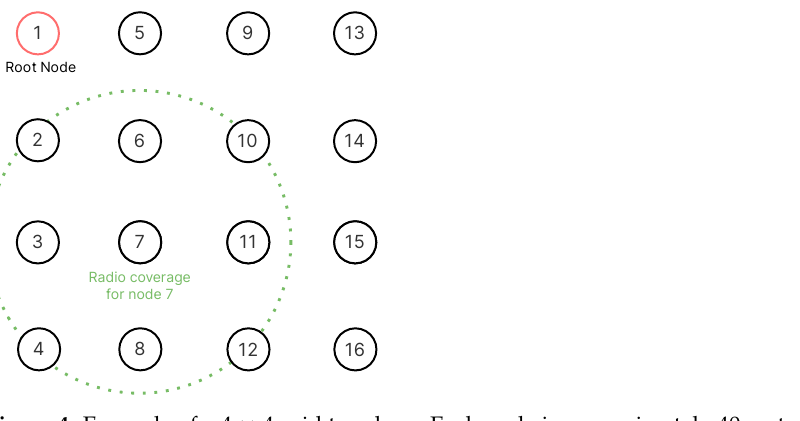
Figure 4. Example of a 4 × 4 grid topology. Each node is approximately 40 meters apart from the others. We assume there are no objects in between